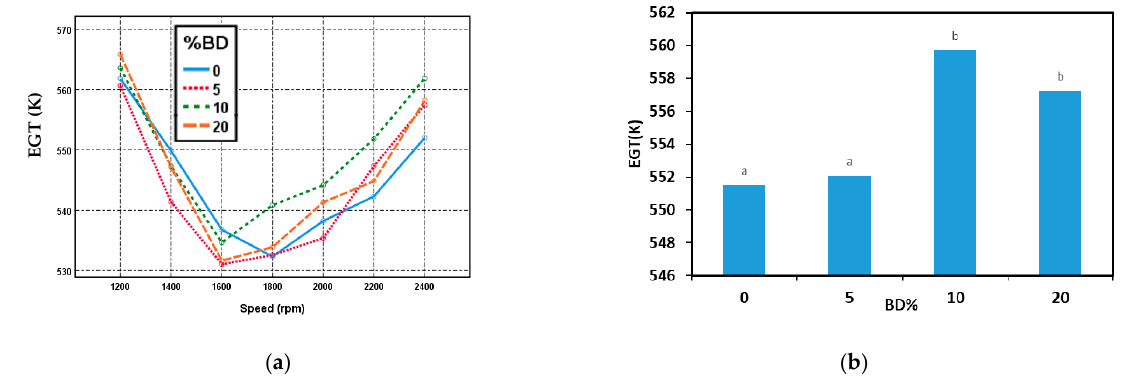
Figure 7. ( a ) EGT vs. S at 100% load; ( b ) mean values of total data of EGT for different speeds and loads. The letters a-d inside the diagram indicate significant differences ( P ≤ 0.05).